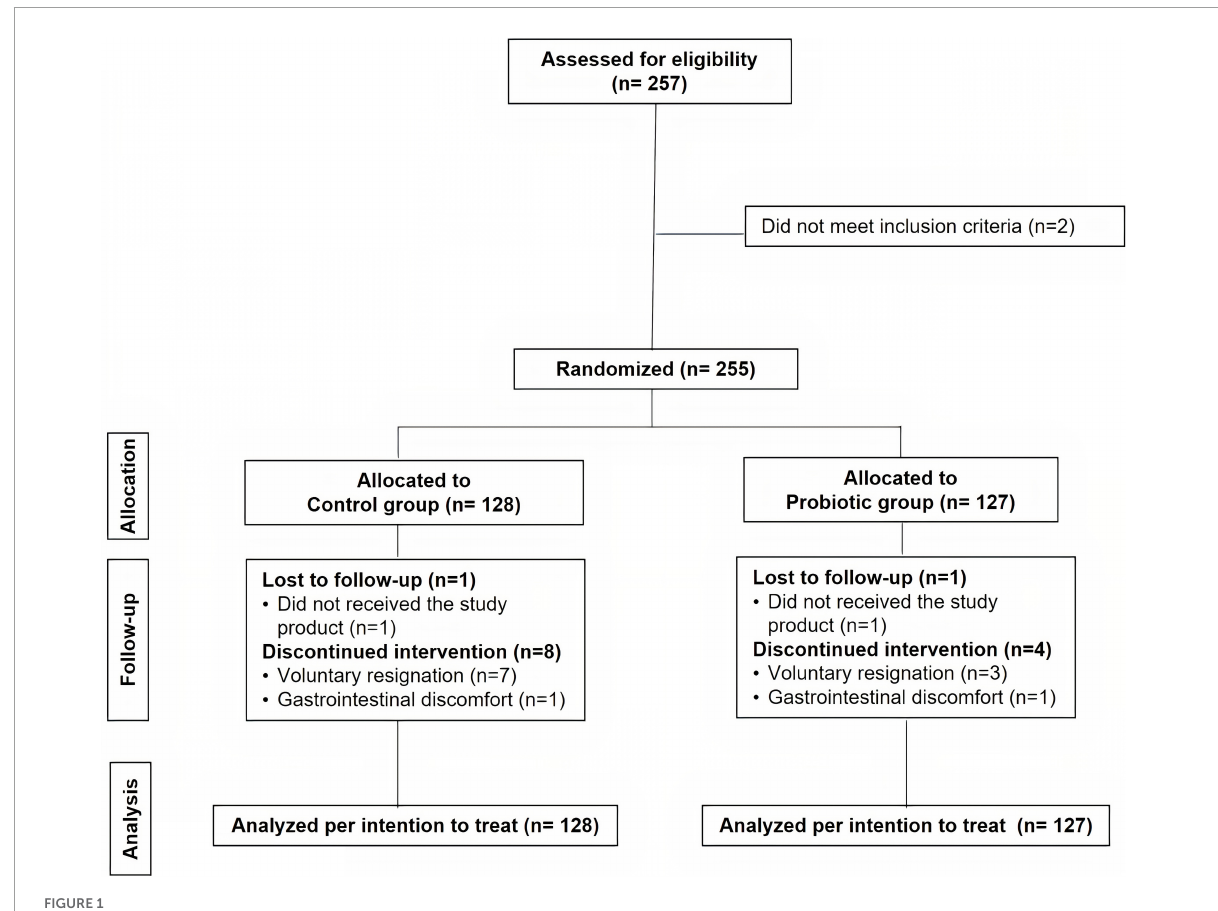
FIGURE1 Flow chart of the